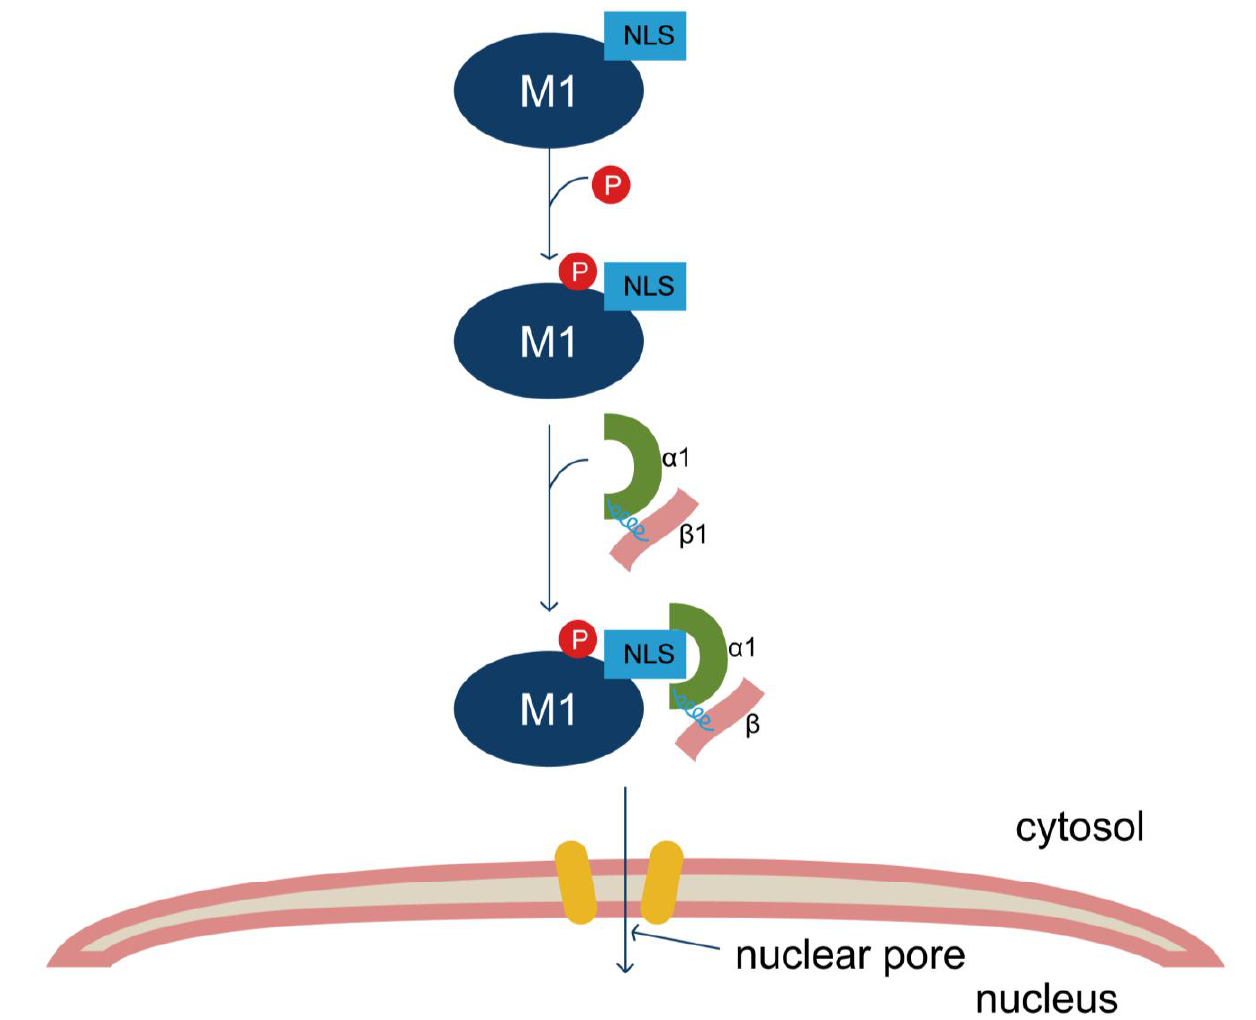
Figure 2. Model of Y132 phosphorylation participating in nuclear import of IAV M1. The conserved tyrosine 132 of M1 is a phosphorylation site. The NLS-neighboring phosphorylated Y132 residue is crucial for the cytoplasmic-nuclear translocation of M1 by increasing the binding capacity of M1 and nuclear import factor importin-α1, subsequently affecting the replication of